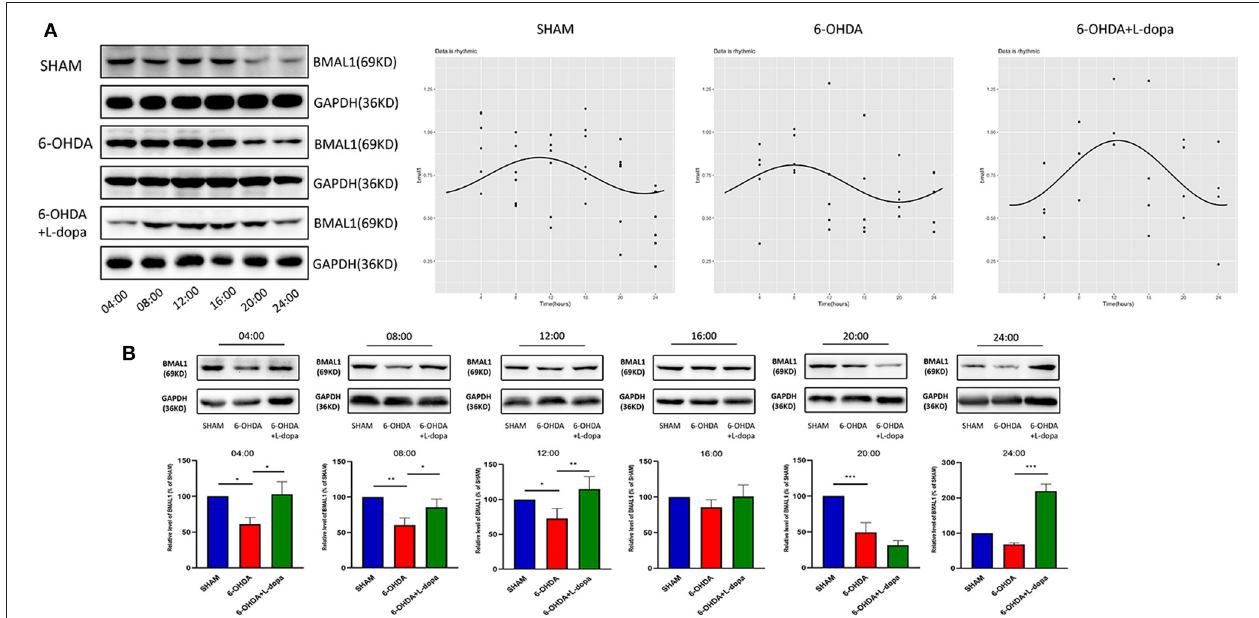
FIGURE 4 | Western blot and the Cosinor analysis of BMAL1 protein. (A) Western blot and the Cosinor analysis of BMAL1 protein in sham, 6-OHDA-lesioned, and 6-OHDA-lesioned + L-dopa groups. The expressions of BMAL1 protein among the sham group, 6-OHDA-lesioned group, and 6-OHDA + L-dopa group at different time points (every 4h since 04:00). All the fitted curves were rhythmic fluctuated. (B) The expression of BMAL1 protein at six time points during a day in sham, 6-OHDA-lesioned, and 6-OHDA + L-dopa groups. * p < 0.05. ** p < 0.01, *** p < 0.001; n = 3–5 at each time point per group.